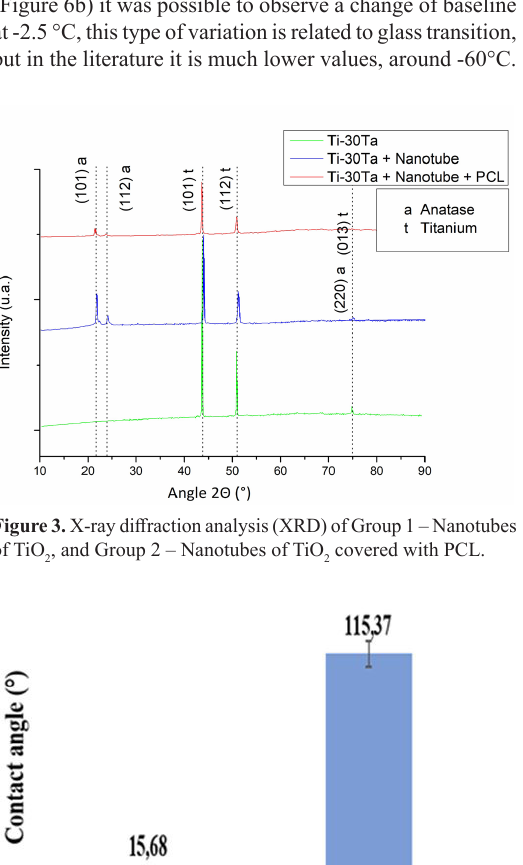
Figure 4. Results of contact angle measurements of Group 1 – Nanotubes of TiO , and Group 2 – Nanotubes of TiO 2 with PCL.